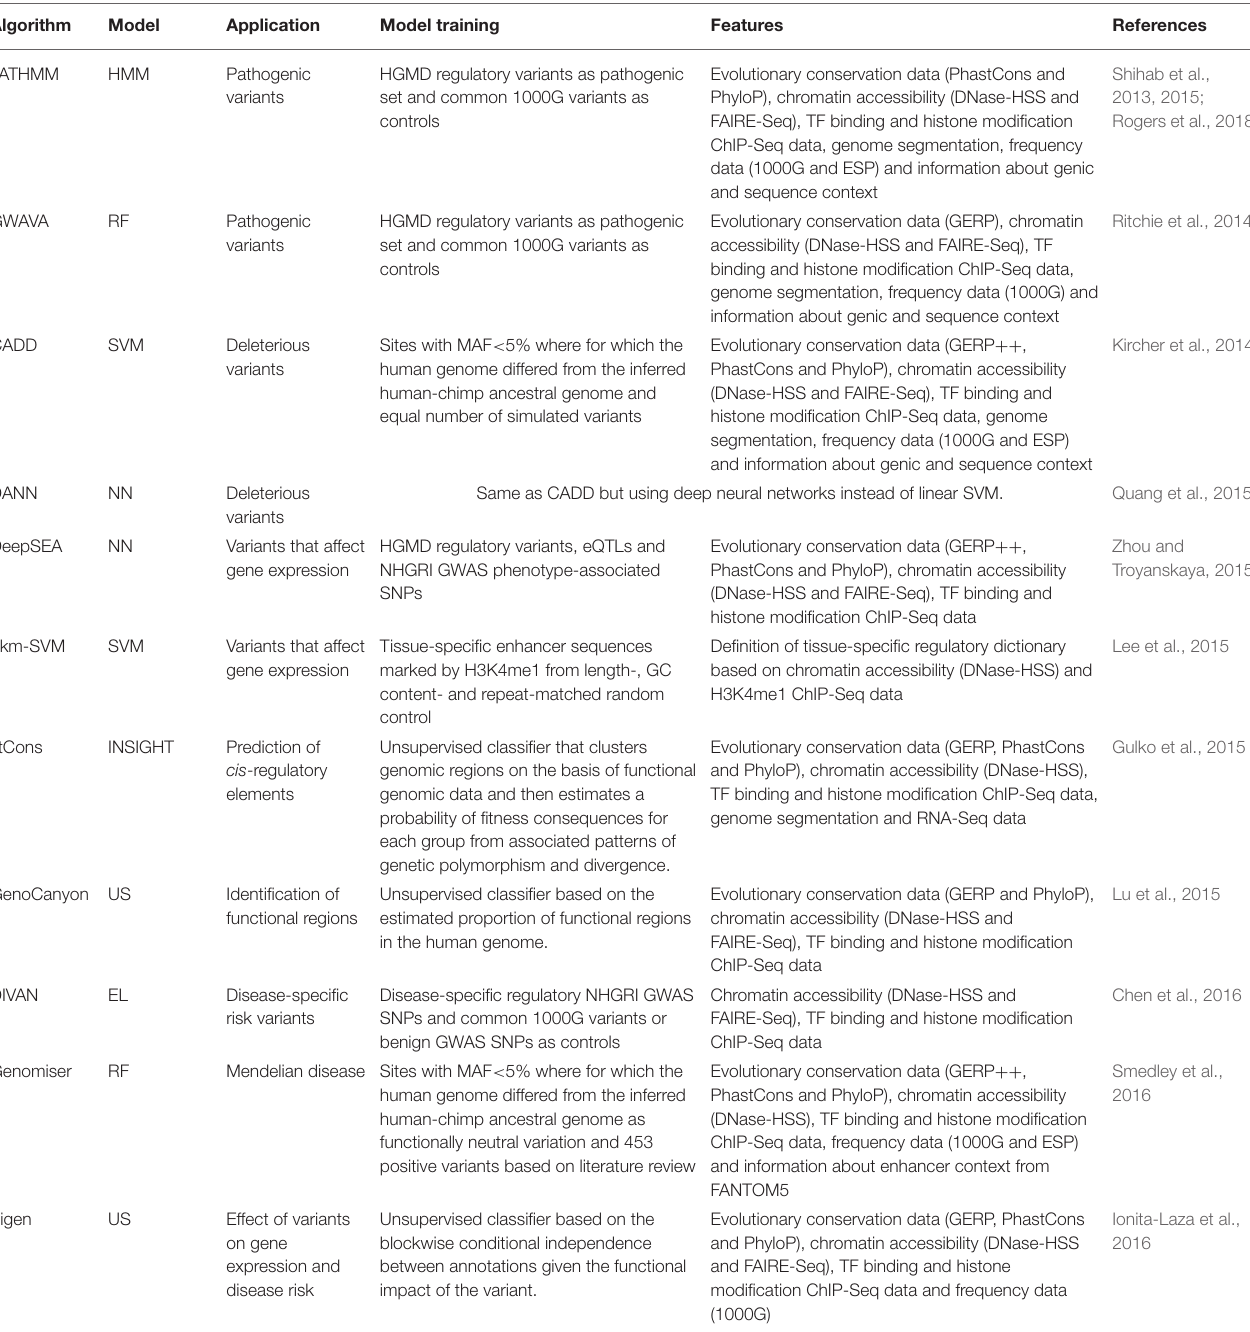
TABLE 4 | Algorithms for the functional interpretation of regulatory variants.